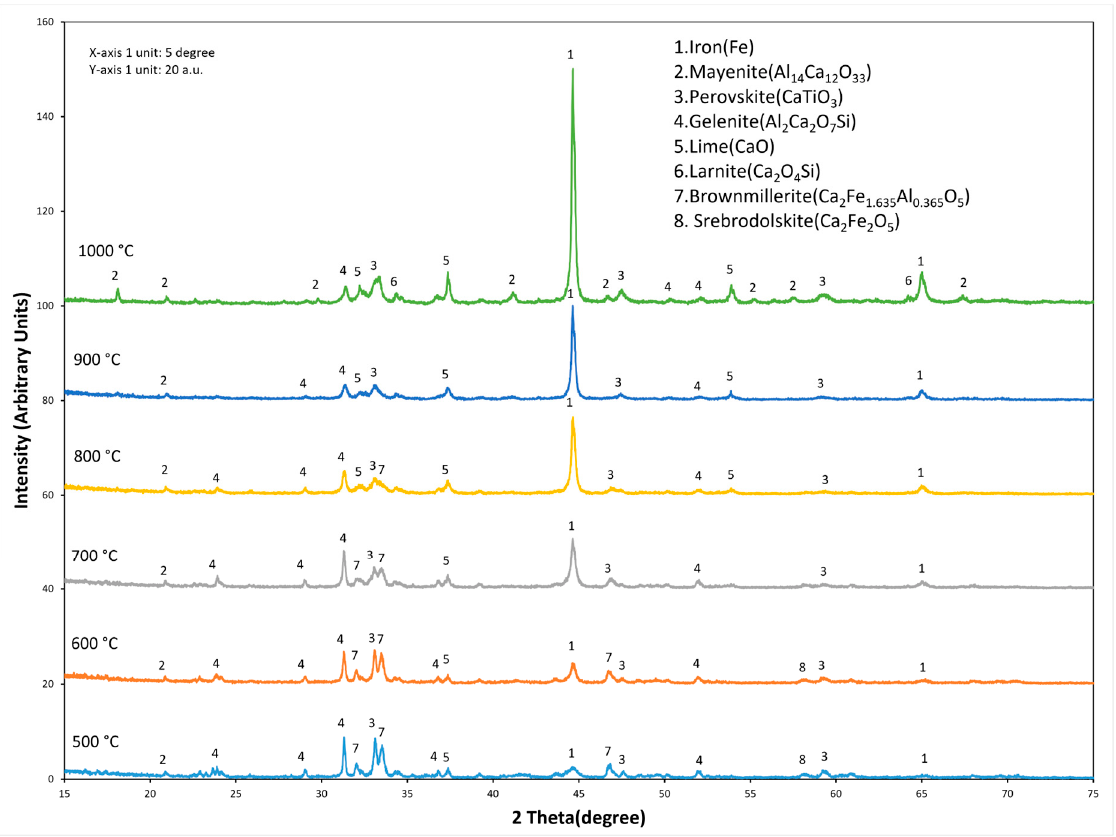
Figure 9. X-ray diffraction analysis of samples reduced at different flow rates of hydrogen with constant reduction time and temperature.